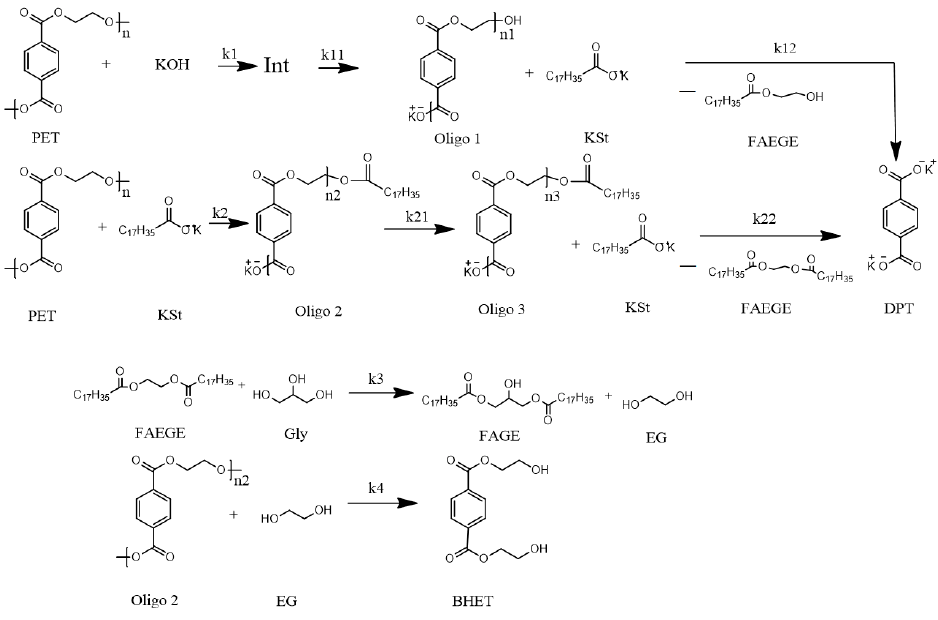
Figure 8. The change in the ether number of the reaction mass over time during the depolymeriza- tion of crude glycerol at 190 °C and a different PET/KSt ratio.